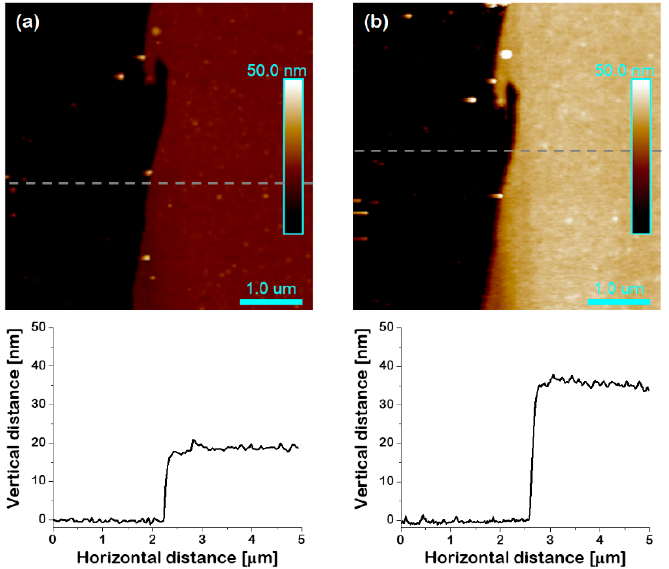
Figure 2. AFM topography images of PMMA brush (Table 1, entry 5) in ( a ) dry and ( b ) wet state (measurements performed in toluene).